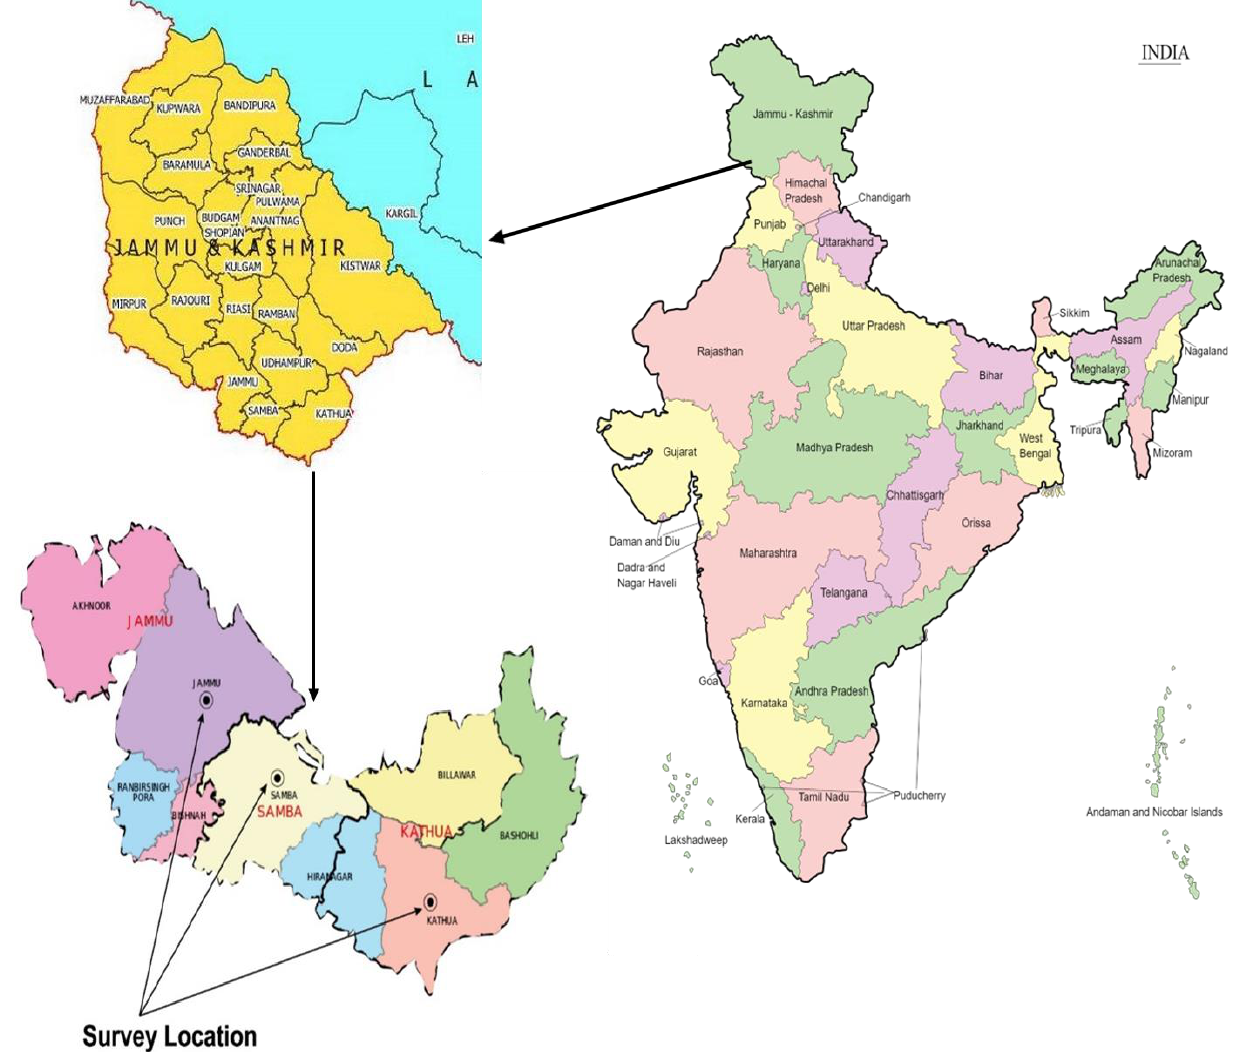
Figure 1. Collection of bacterial leaf blight samples from basmati-rice-growing area of Jammu.